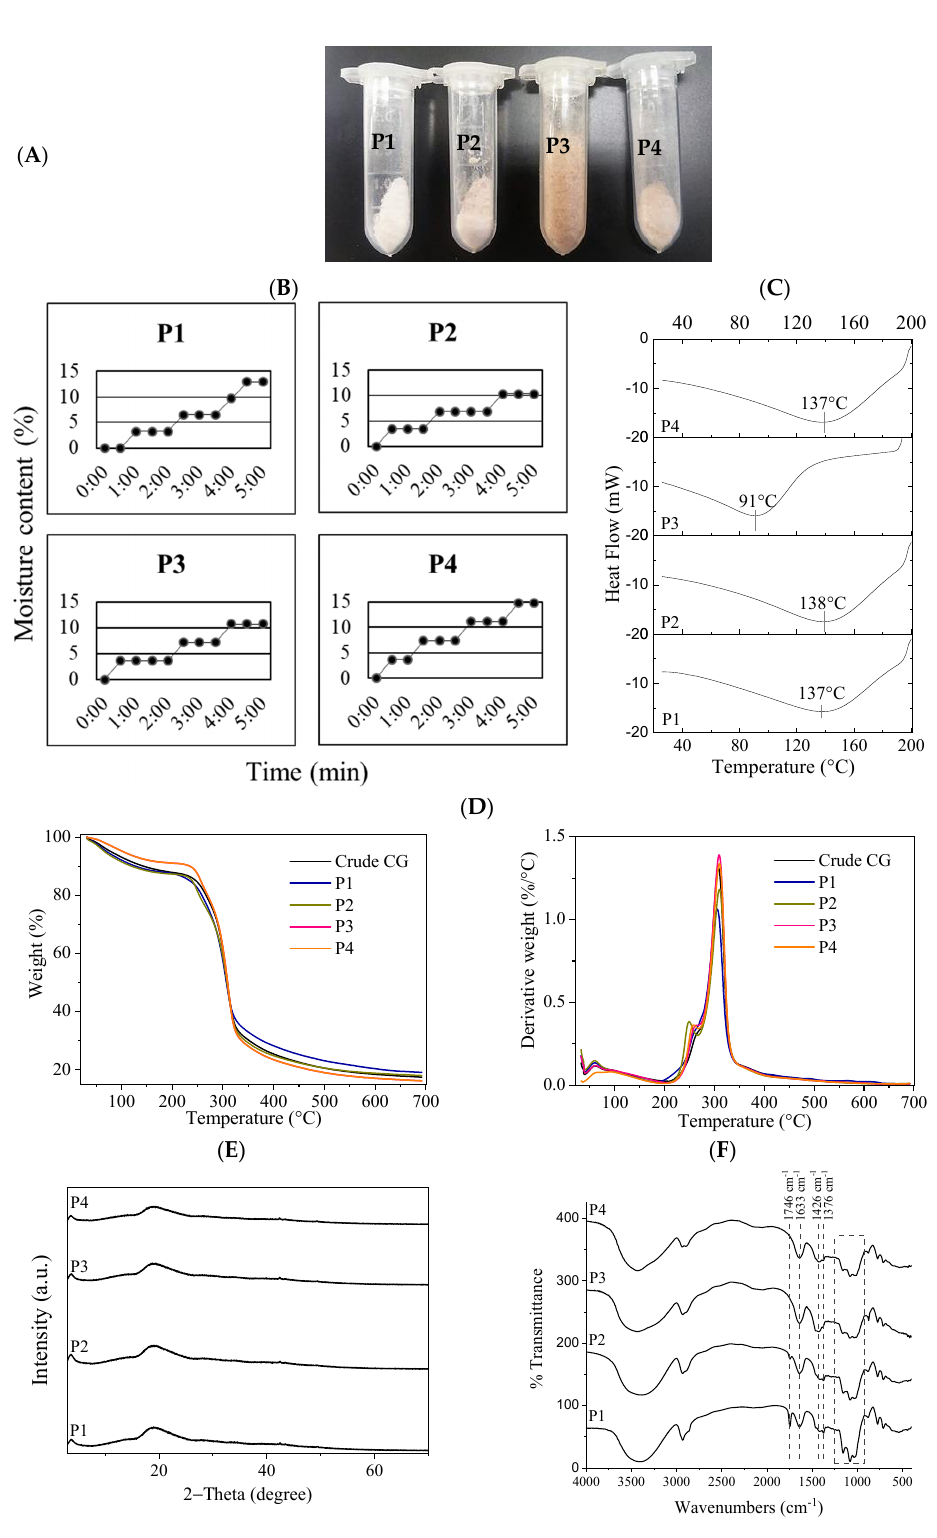
Figure 2. ( A ) Cashew gum after purification by different methodologies, using hydrogen peroxide (P1), acetone (P2), ultrasonic probe sonicator (P3), and microwave (P4); ( B ) Percentage of CG moisture content after drying by infrared radiation at 60 ◦ C; ( C ) DSC curves of CG from room temperature to 473.15 K (200 ◦ C) and heating rate of 283.15 K (10 ◦ C); ( D ) TG/DTG curve of CG under dynamic nitrogen atmosphere (50 mL · min − 1 ), β = 10 ◦ C, and m = 8.5 ± 0.5 mg; ( E ) X-ray Diffractogram of CG with 2 θ reflection angle, monitored from 2 ◦ to 70 ◦ at a scan speed of 1 ◦ min − 1 , 40 kV/30 mA; ( F ) FTIR spectra of CG in Kbr